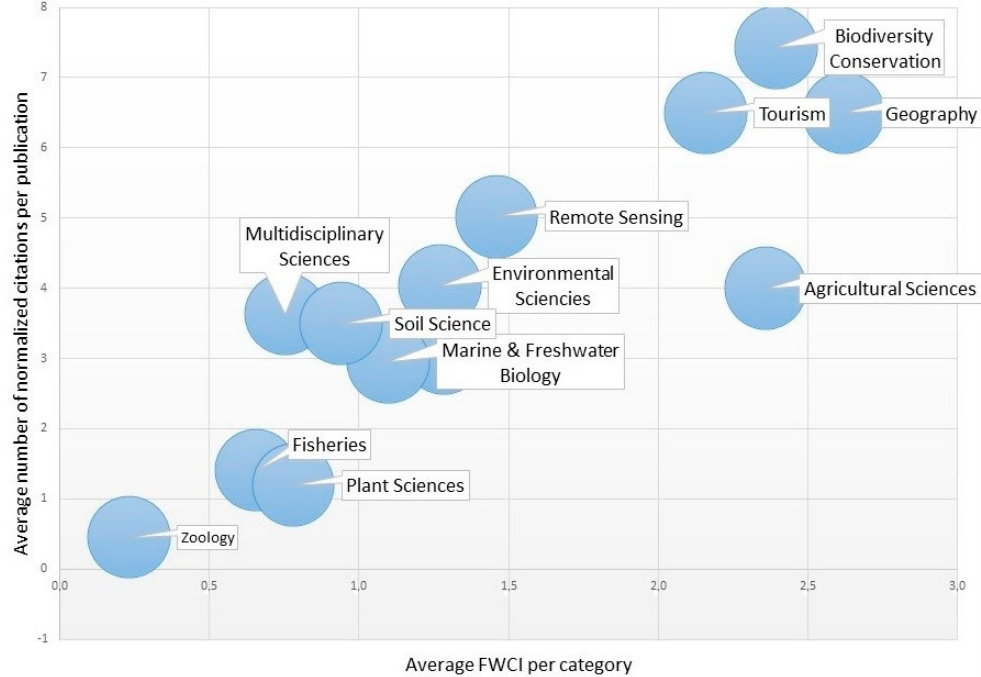
Figure 7. Relationship between the mean FWCI (Field-Weighted Citation Impact) (x-axis) and the average number of normalized citations of articles according to each subject category of the publishing journals (y-axis).